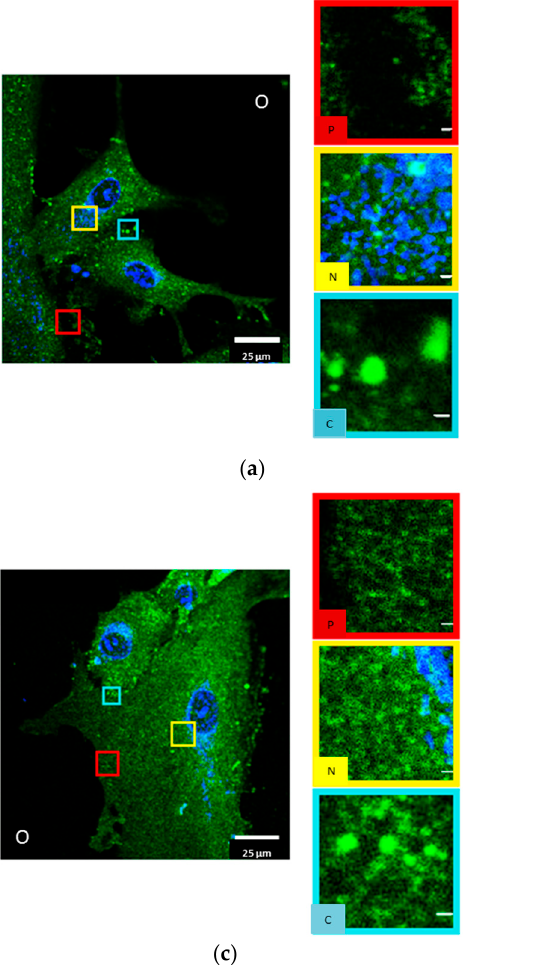
Figure 7. CLSM images of BJ cells ( a ) untreated; ( b ) after 4 Gy irradiation and 50 min recovery; ( c ) after 1-hour NRG1 treatment; ( d ) after 1-hour trastuzumab treatment; blue: Cell nucleus after Hoechst34580 staining; green: Cx43 specific antibody labelling and Alexa488 staining. (O) Overview with selected regions. (P) Image section of the periphery of the cell. (N) Image section of the perinuclear region of the cell. (C) Image section of the contact region of cells. Scale bar 1 µm.